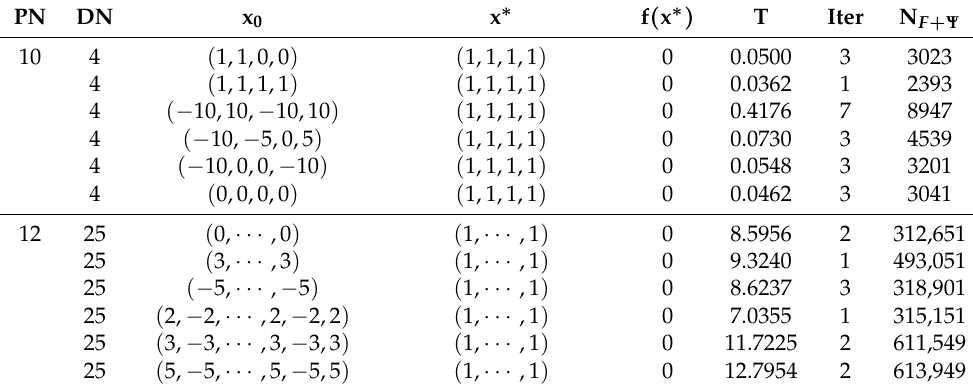
Table 4. Numerical results of Problems 10 and 12.